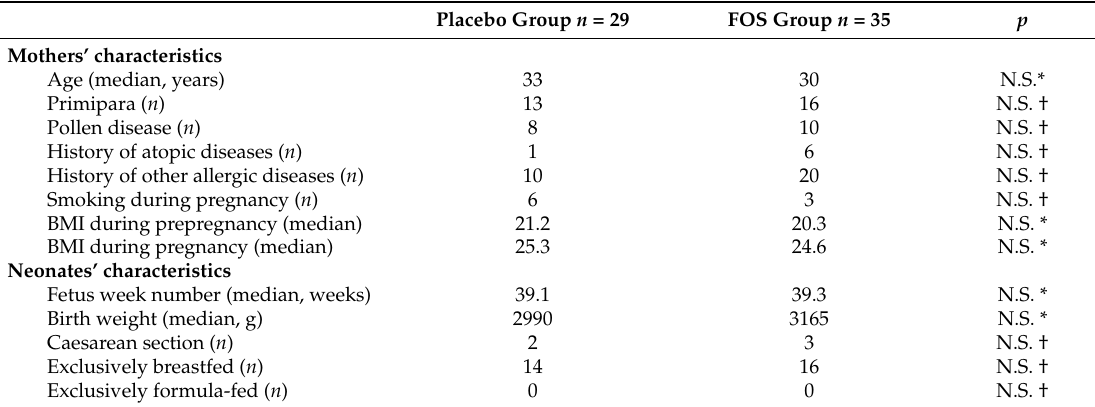
Table 1. Characteristics of the mothers and the